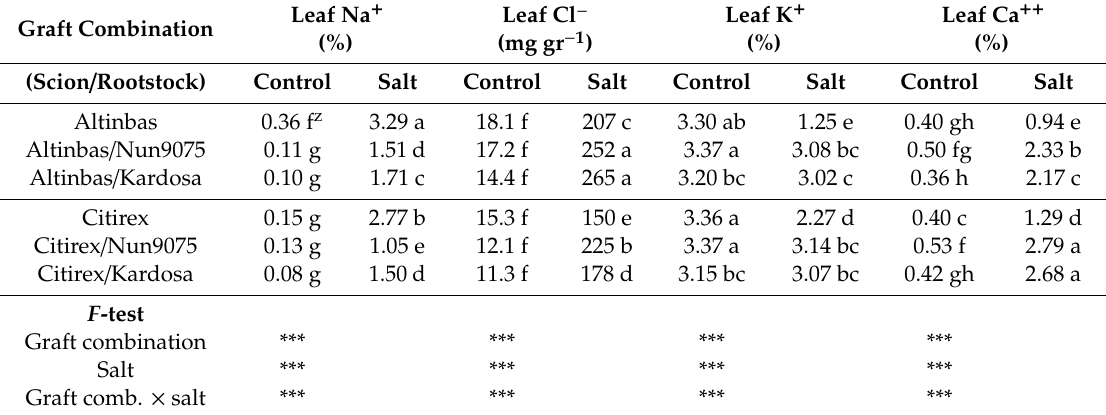
Table 3. Leaf Na + , Cl − , K + , and Ca ++ contents of melon graft combinations under control (1.5 dS m − 1 ) and salt stress (8.0 dS m − 1 )